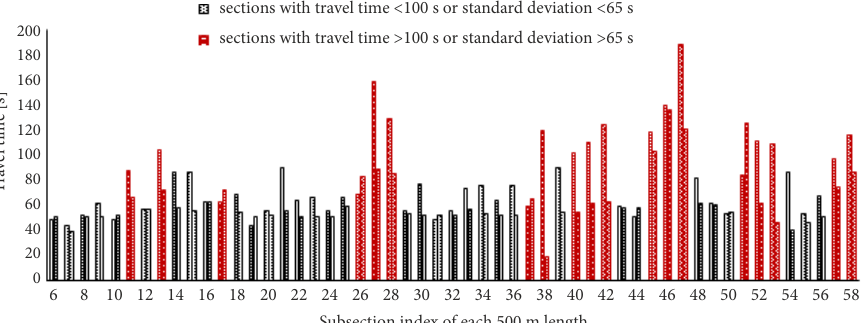
Figure 8. HMHV and LMLV sections identified based on fixed